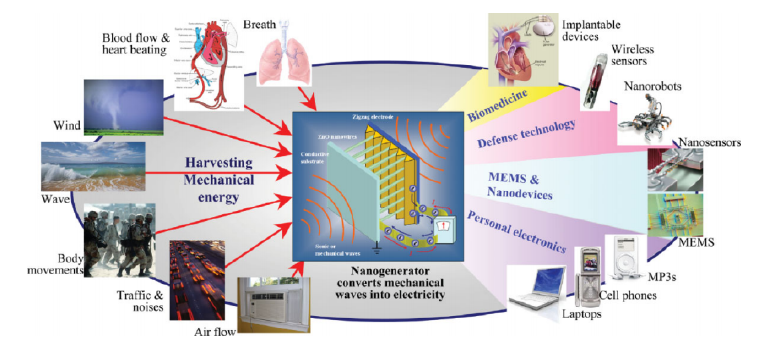
Figure 8. Possible applications of piezoelectric polymer/paper substrates; important areas are energy harvesting and sensing applications; Reprinted, with permission, from [84], c (cid:13) 2008 Wiley online